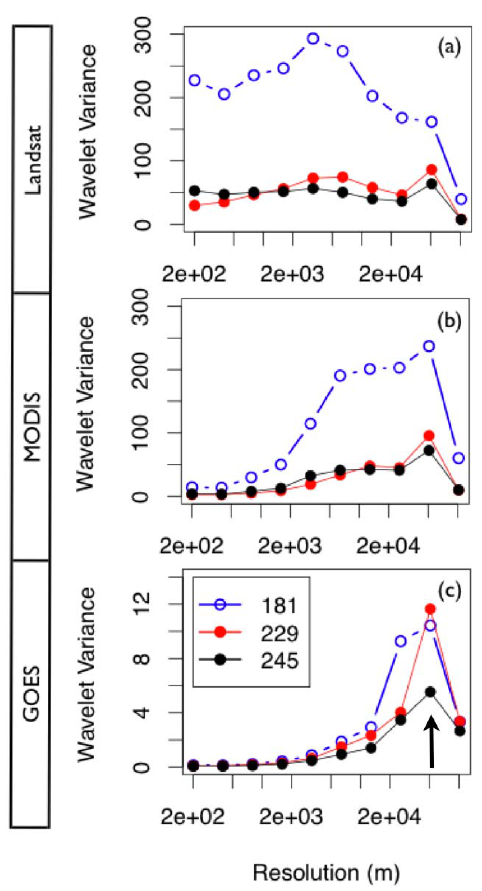
Fig. 2. Spatial wavelet spectra [Power m − 1 ] for evapotranspira- tion for each sensor (Landsat, MODIS, and GOES) for each day of consideration (181, 229, and 245). The arrow denotes the 51km